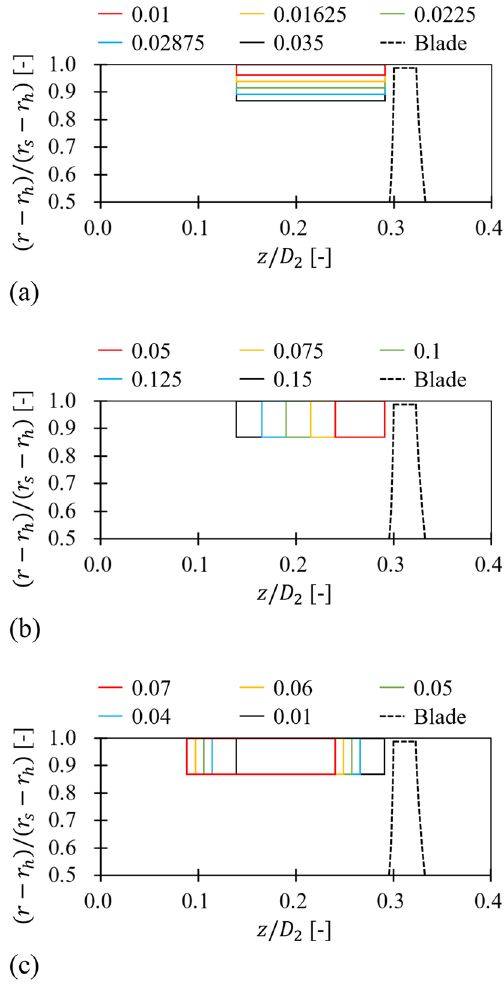
Figure 3. Configuration for ( a ) radial length ( l r ), ( b ) axial length ( l a ), and ( c ) axial gap ( δ